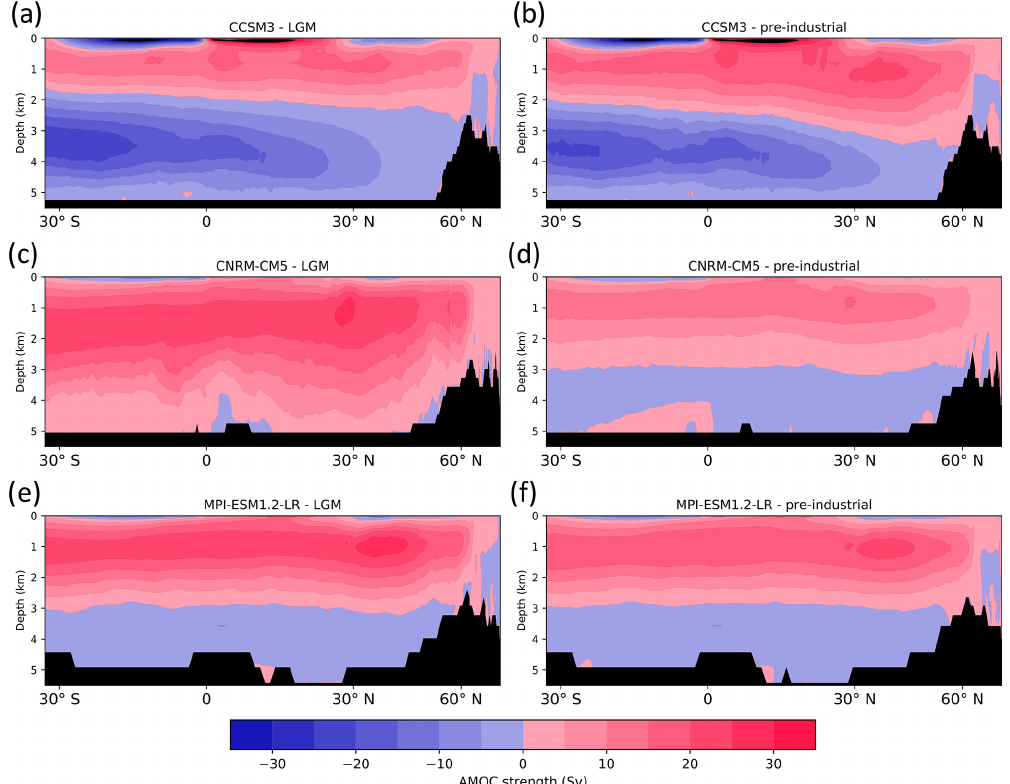
Figure 8. Examples of three typical cases of AMOC structure in PMIP models. Panels (a) and (b) : AMOC in agreement with proxy data (CCSM3); (c) and (d) : too deep LGM intrusion of NADW (FGOALS-g2); (e) and (f) : AMOC with little difference between the LGM and the pre-industrial period